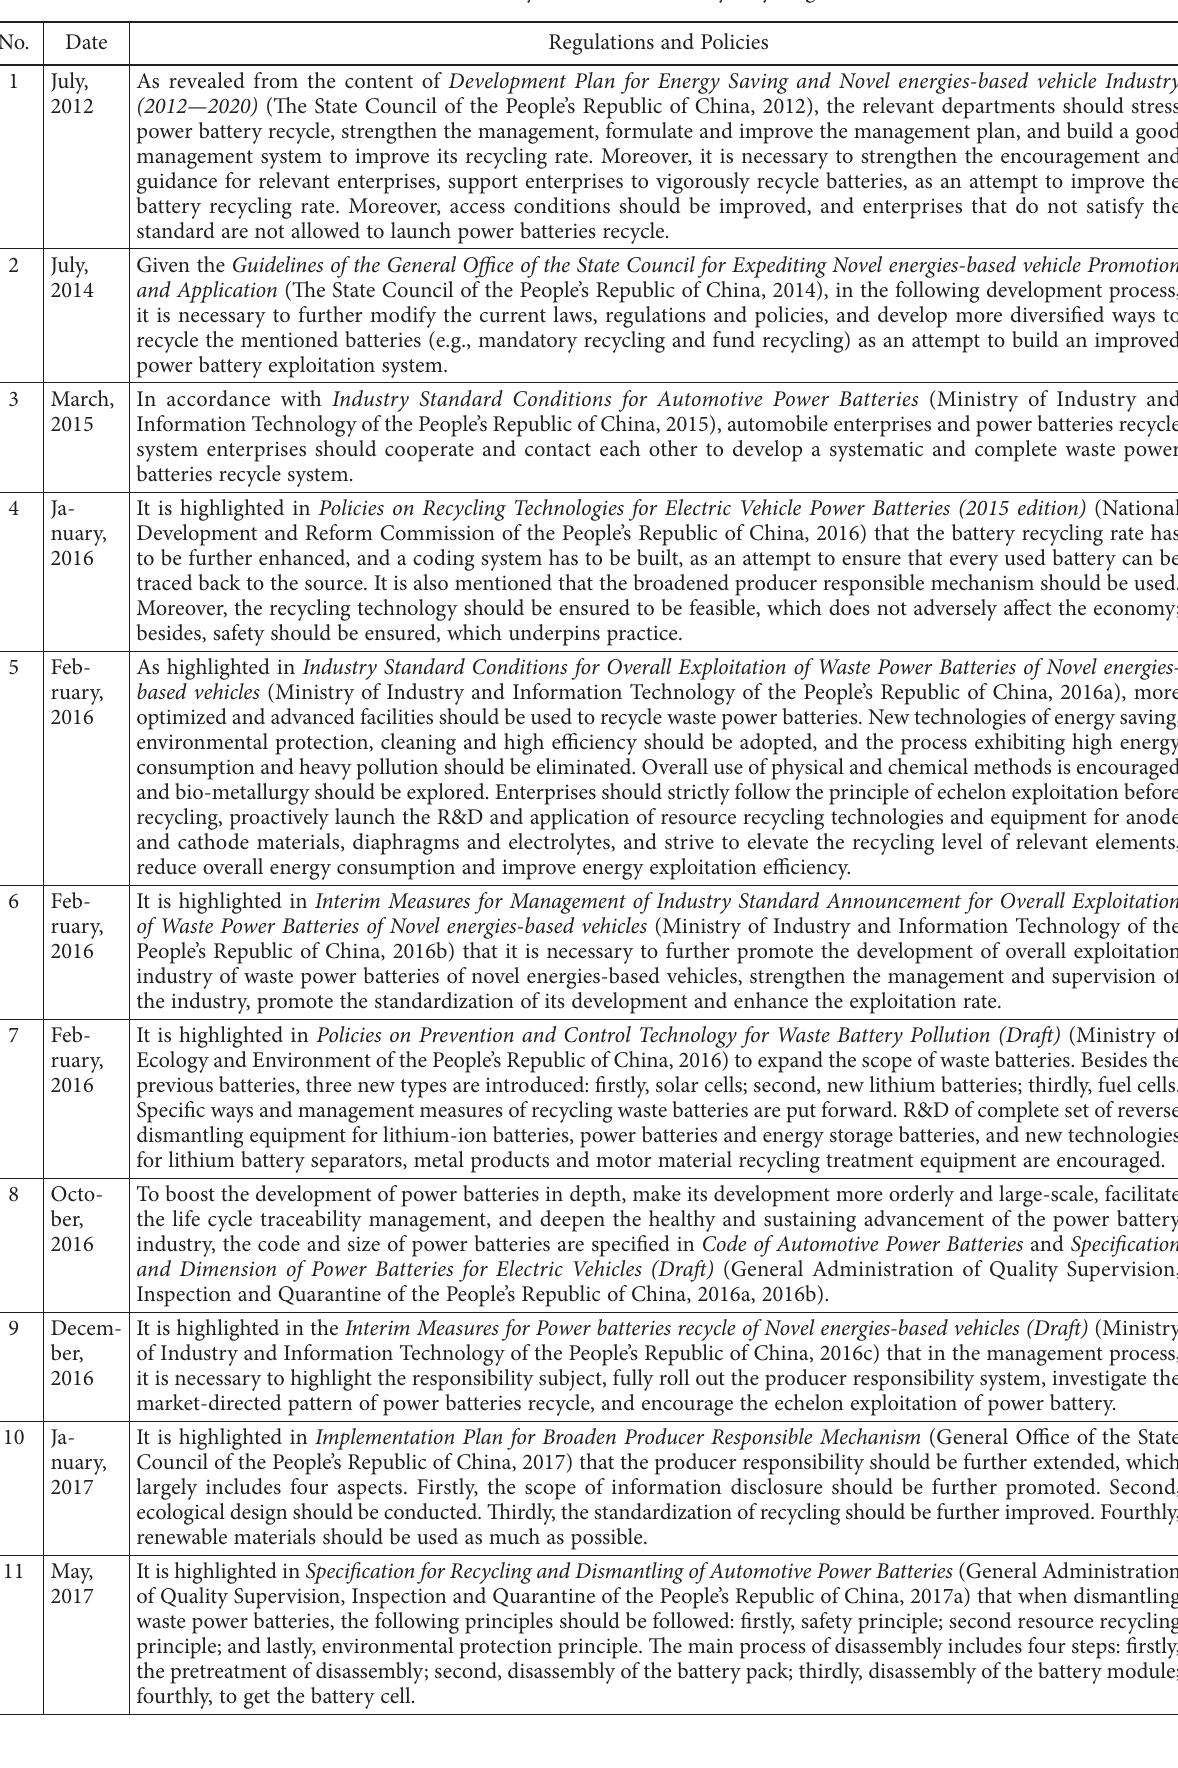
Table 1. Policies and industry standards on battery recycling in